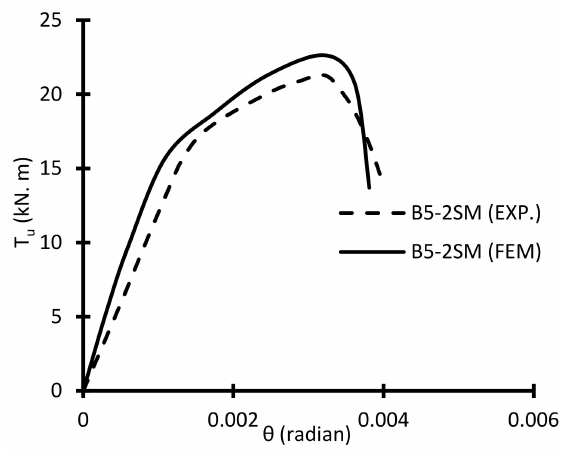
Figure 40. Torque-twist curves of the beam B5-2SM (FEM and